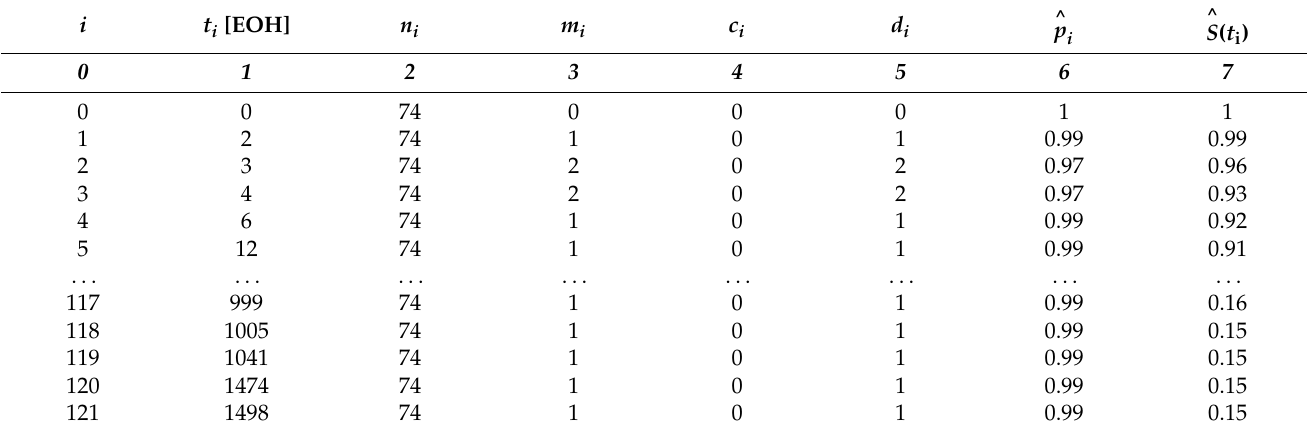
Table 2. Sample data necessary to calculate the K-P estimator and its values, for the i -th times.